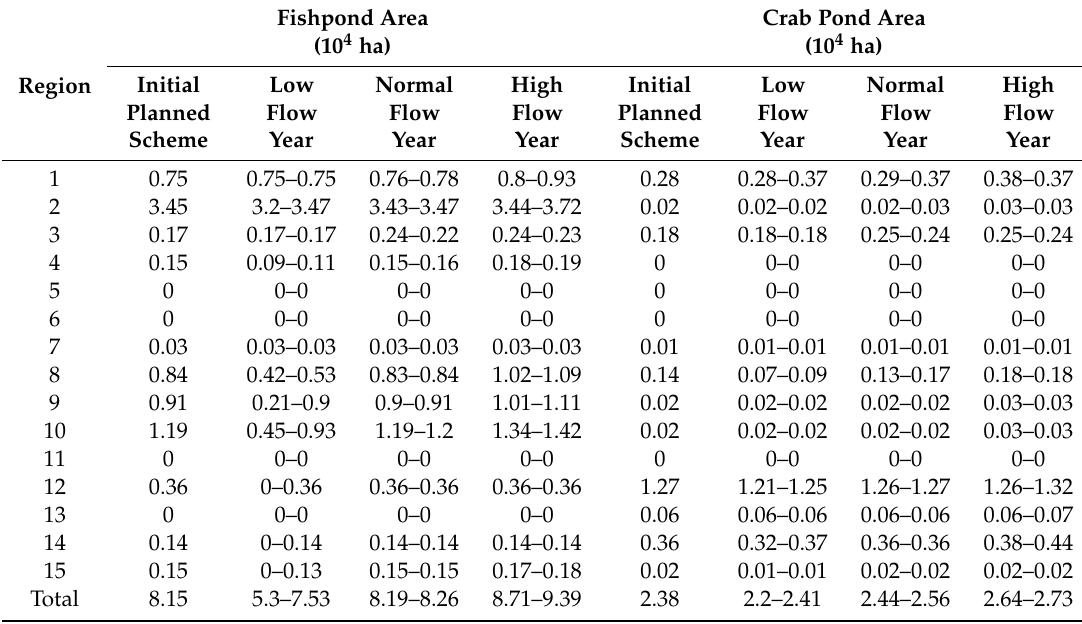
Table 1. Interval value of the restored fishpond area and the crab pond area.